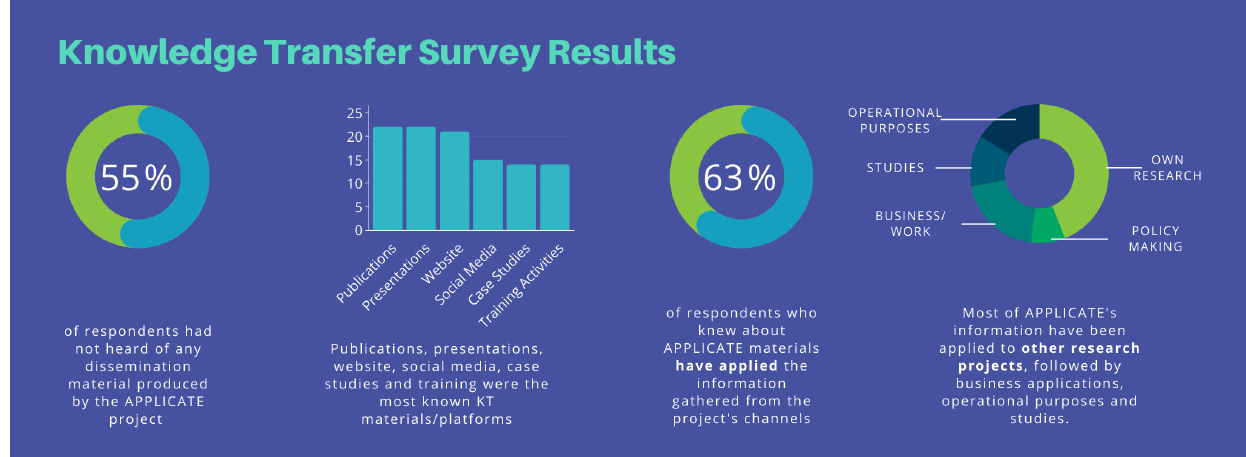
Figure 4. Summary of the main results of the APPLICATE’s survey on knowledge transfer